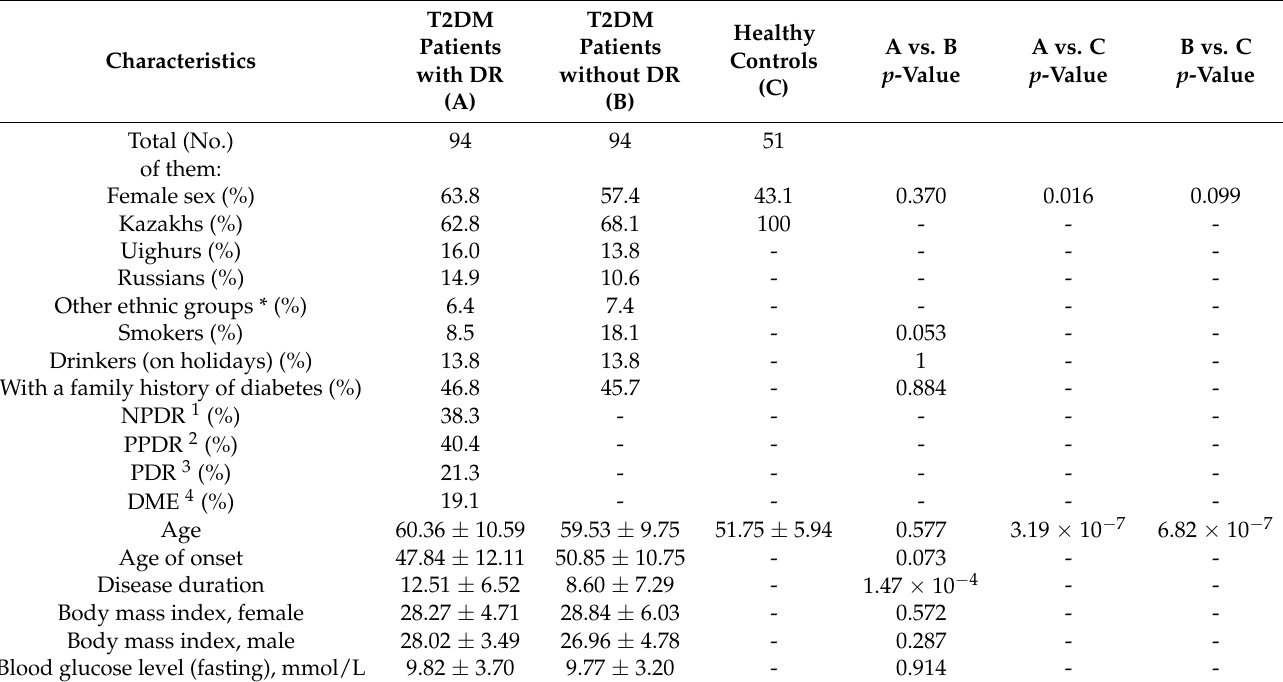
Table 1. Demographic and clinical characteristics of the study groups.